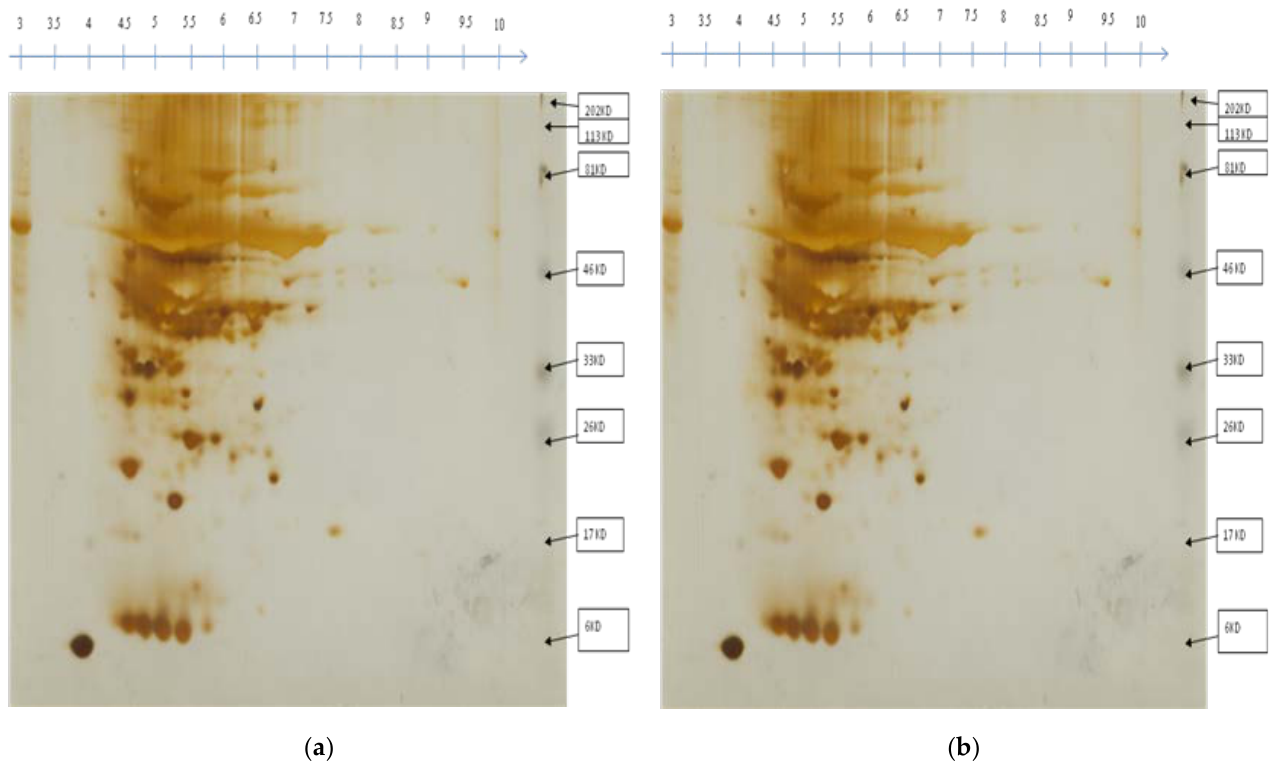
Figure 3. Representative gel image following two-dimensional PAGE analysis of leaf protein extracts of Kashi Amrit ( a ) and EC-317-6-1 ( b ). Protein spots circled are the proteins present in the controlled condition.